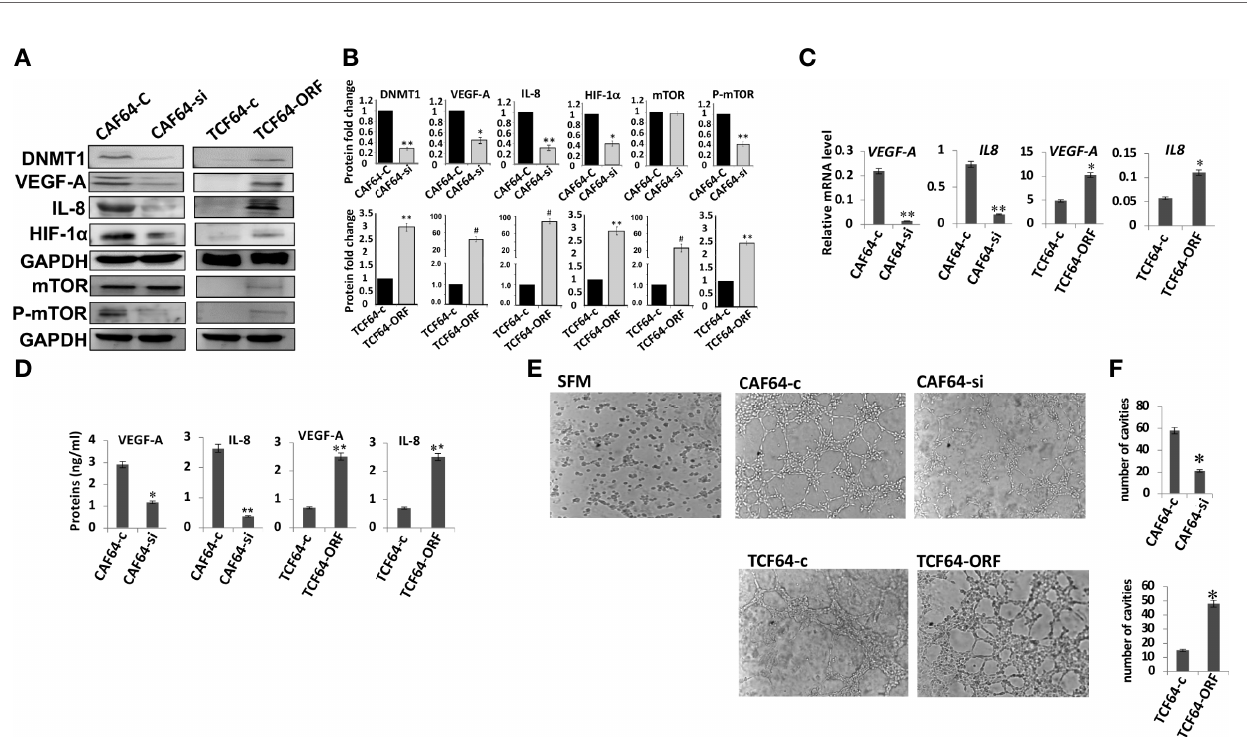
FIGURE 1 | DNMTl controls the expression of VEGF-A and IL-8 in breast stromal fi broblasts and promotes their pro-angiogenic effects in vitro . CAF-64 cells were transfected with DNMT1-siRNA (CAF64-si) or with a plasmid bearing the DNMT1 ORF (TCF64-orf). A scrambled sequence (CAF64-c) and an empty vector (TCF64- c) were used as controls, respectively. Whole-cell lysates were prepared, and then were used for immunoblotting analysis using speci fi c antibodies against the indicated proteins. (A) Immunoblotting analysis (B) The histograms show the averaged protein level fold changes relative to the respective controls after normalization against the internal control GAPDH, while the level of the phospho-protein was further normalized to the level of the total protein. Error bars represent mean ± S.D (n=3). * P <0.05, **P<0.01 and # P<0.0001. (C) Total RNA was extracted from the indicated cells and the mRNA levels of the indicated genes were assessed using qRT-PCR. Error bars represent mean ± S.D (n=3). * P <0.05 and **P<0.01. (D) SFCM from the indicated cells were collected after 24 h and the levels of the indicated proteins were determined by ELISA. Error bars indicate mean ± S.D (n=3). * P <0.05 and **P<0.01. (E) SFCM from the indicated cells were collected and used to treat HUVEC cells previously plated on matrigel (96-well plate), then incubated at 37°C for 8 hr. (F) Histograms show the average number of formed cavities. Error bars represent means ± S.D (n=3). * p